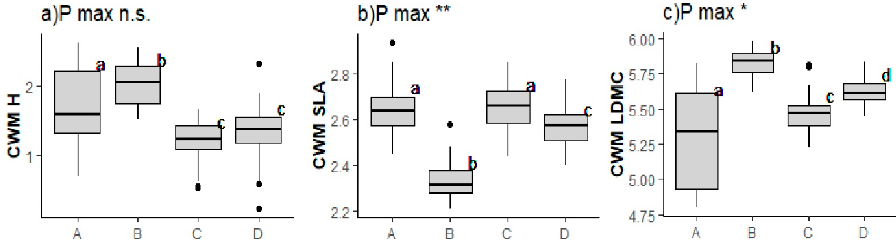
Figure A2. Boxplots comparing the functional characteristics of the analyzed plant communities (A: Leucopoa dimorpha scree community, B: Sesleria juncifolia steep slope community, C: Plantago atrata snowbed community, D: Silene acaulis ridge community) in terms of community-weighted mean (CWM) for the functional strategies related to plant height ( a ), SLA ( b ) and LDMC ( c ). Boxplots with different letters indicate statistically significant differences among them after Tukey’s post hoc test ( p < 0.05). Statistical significance of ANOVA analysis is also reported (n.s. p > 0.05; * p < 0.05; ** p < 0.01).